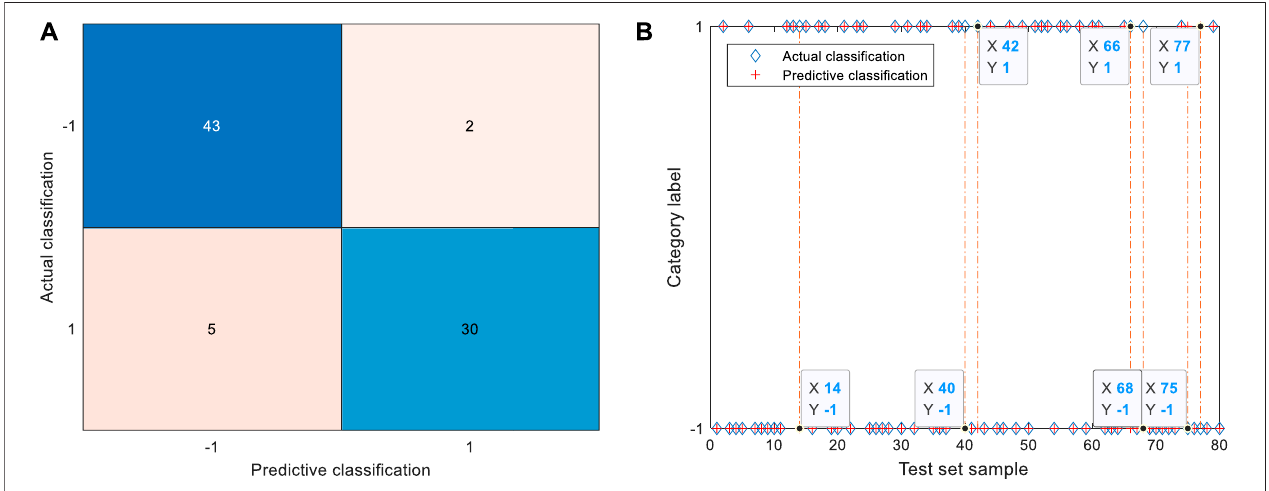
FIGURE 5 | Identi fi cation results of 25 physical signs by GSA-SVC. (A) Confusion matrix of test set. The TP is 43, TN is 30, FP is 5, and FN is 2; (B) Identi fi cation results of test set. The 14th, 40th, 42nd, 66th, and 68th samples were misclassi fi ed as abnormal coal miners in the test set. The 75th and 77th samples were misclassi fi ed as normal coal miners in the test